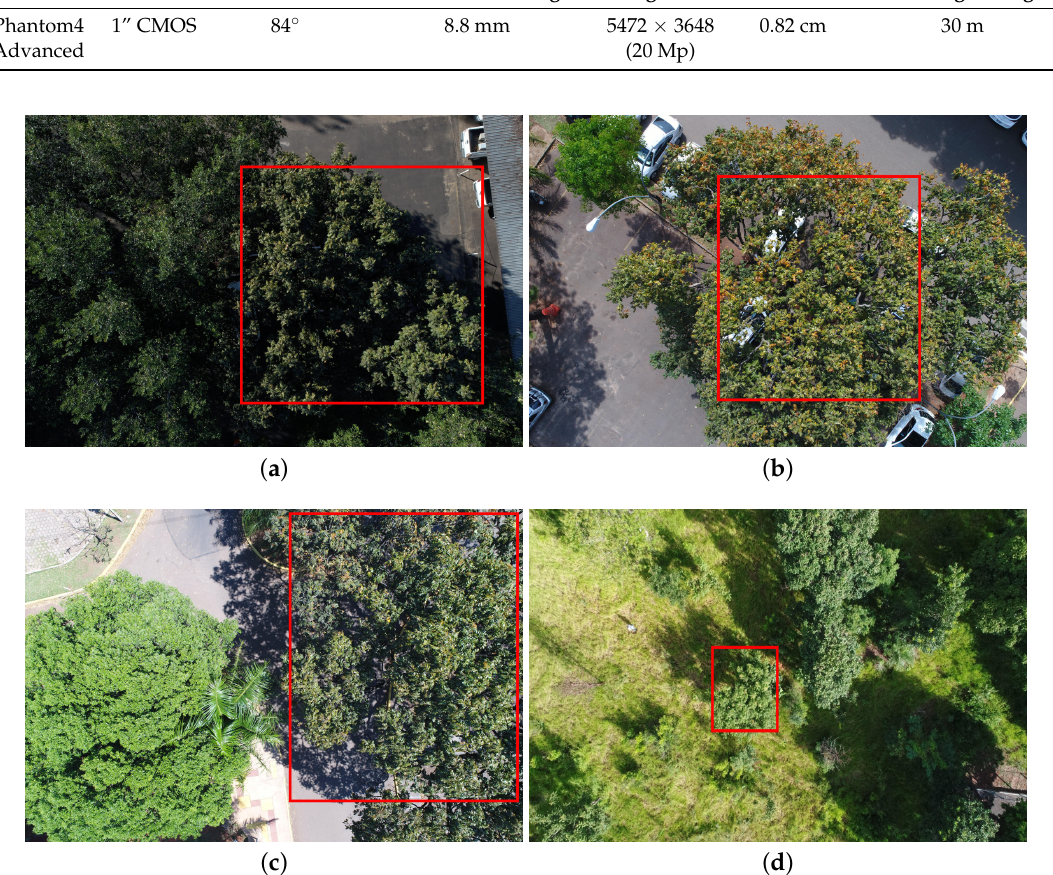
Figure 2. Examples from the dataset: images captured on: ( a ) 26 August 2018; ( b ) 21 September 2018; ( c ) 22 September 2018; and ( d ) 20 February